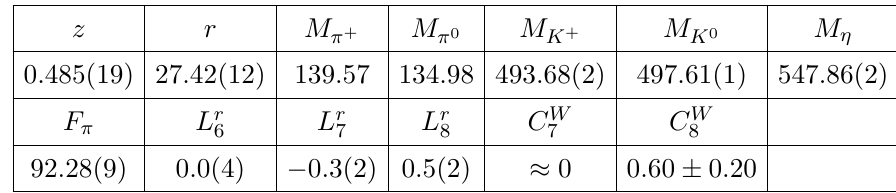
Table 1 . Numerical inputs used in this paper. The pion decay constant F (cid:25) , and experimental meson masses M P are in units of MeV, and are taken from ref. [33]. The renormalized LECs L r in units of 10 (cid:0) 3 ; they correspond to values at scale (cid:22) = 770 MeV and are taken from ref. [68]. The NNLO anomalous LECs C W and C W are given in units of 10 (cid:0) 3 GeV (cid:0) 2 ; for their determinations, 7 8 see the text. For the quark mass ratios de(cid:12)ned as z = m u =m d and r = m s = ^ m , we take the FLAG average of the N f = 2 + 1 lattice results